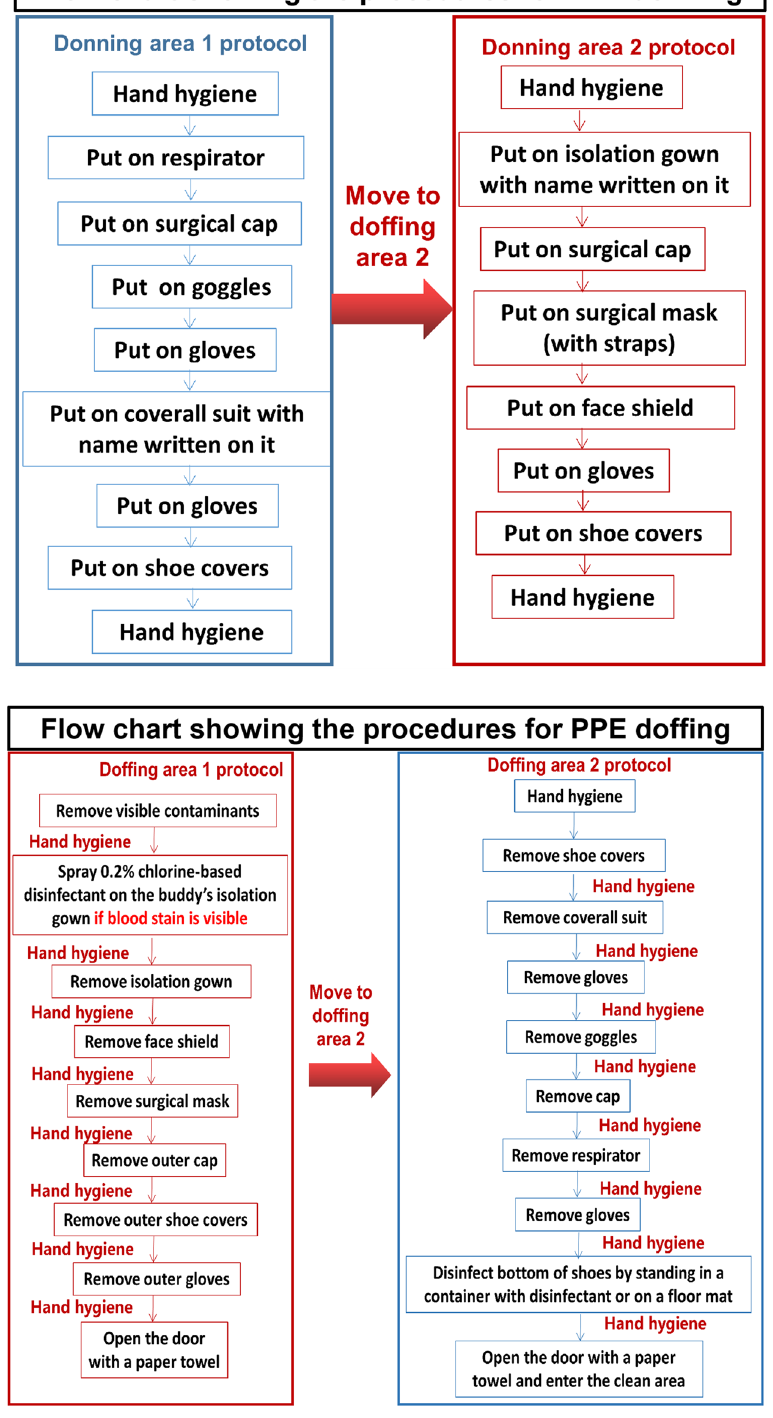
Figure 1: Flow chart showing the procedures for PPE donning and do ffi